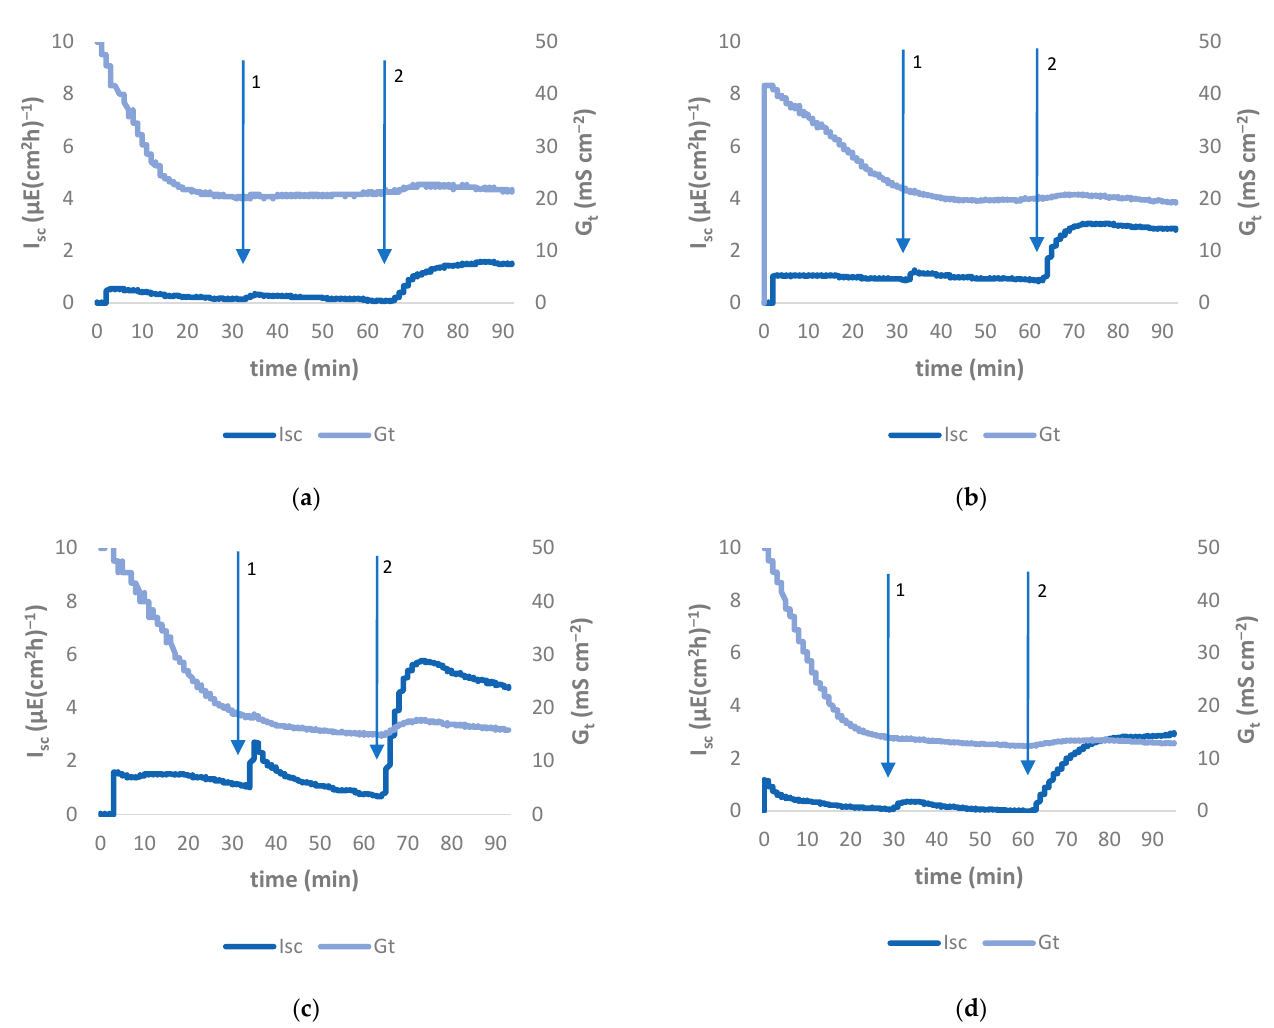
Figure 3. Time courses of I sc and G t in caecal tissue using Ussing chamber experiment of ( a ) Group 0, ( b ) Group 1, ( c ) Group 2, ( d ) Group 3. Arrows indicate addition of pharmaceuticals: 1 carbachol, 2 forskolin. The time course of the I sc of Group 2 ( c ) differs statistically significantly from Group 0 ( p < 0.05).